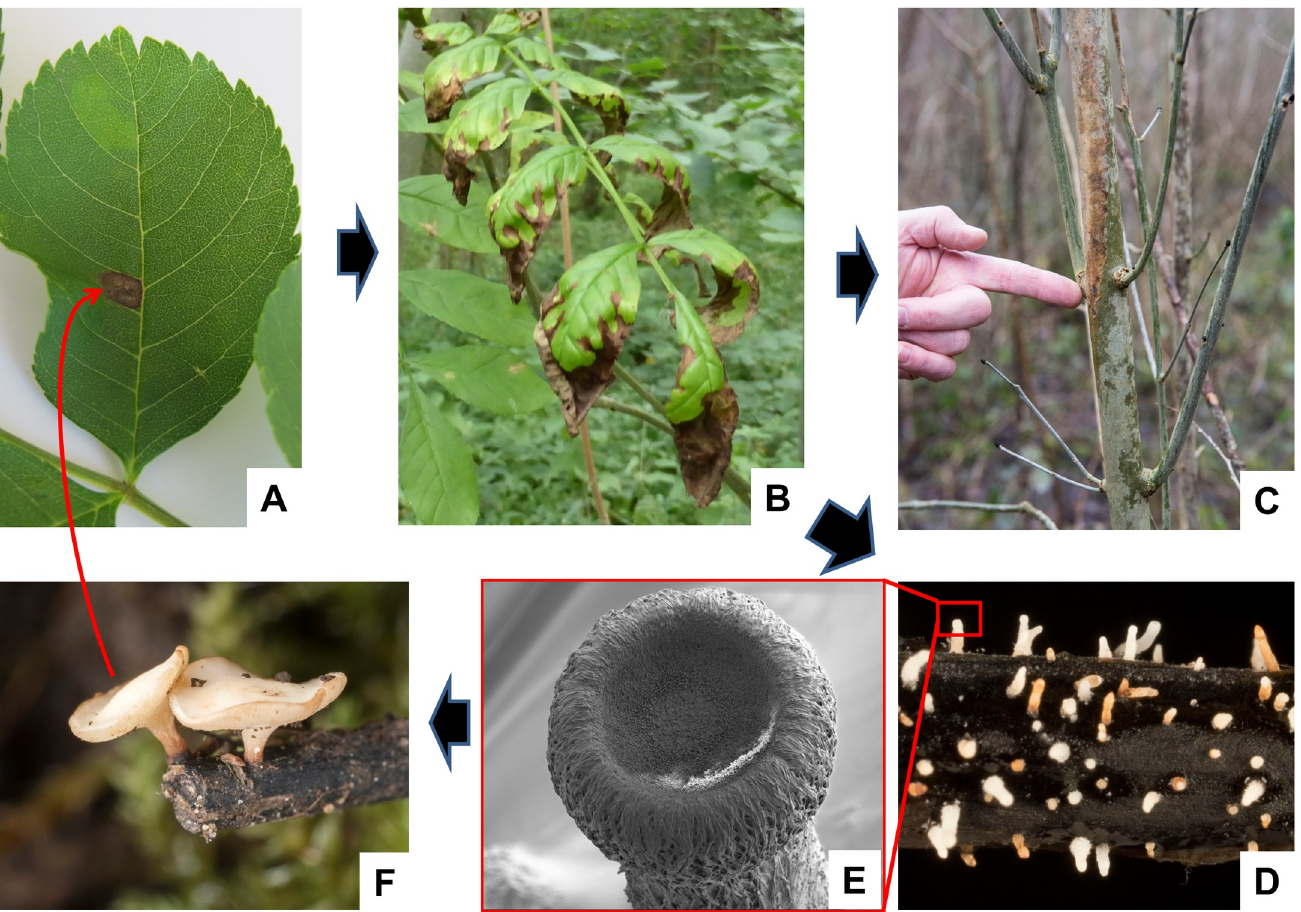
Fig 1. Life cycle of the H . fraxineus .(A) Individualascospores of Hymenoscyphus fraxineus land on ash tree leaves in early summer months causing necrotic lesions. (B) Heavierinfectionscause severe symptoms on ash leaves and the fungal myceliumgrows down throughthe leaf stems into the woody parts of the tree, where it continuesto grow, causingdiamond-shapedlesions (C) that can eventuallyencircle the branch, cutting off nutrient exchangewith the leaves. Infected leaves are shed in autumn and by early summer, the leaf stems show early stages of growth of H . fraxineus prefruiting bodies (D) that are about 0.1 mm in diameter, and one is illustrated by scanningelectron microscopy (E) . Fertilization of these, probablyby conidiosore spermatia, promotes the formation of mature fruiting bodies (F) that fire ascosporesup into the air where they are carried to ash leaves to completethe life